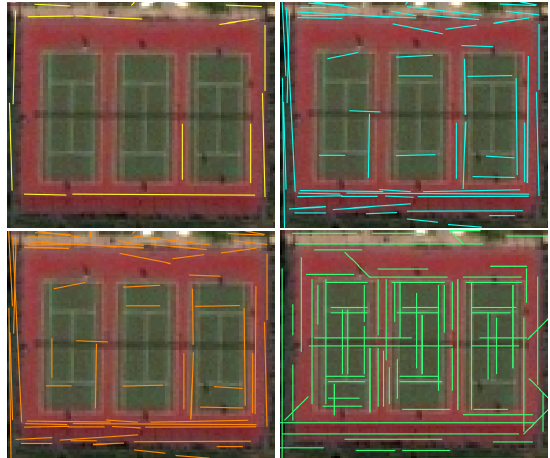
Figure 8. Overlayed results of lines detected by LSD (Yellow), EDLines(light blue), Hough Lines (Orange) and edge accumulator (green). The effects of edge pixels can be seen around the red circles on the slightly rotated lines. detected edges. Firstly, detected and ground truth edges were paired using a proximity threshold of 1.5 pixels. Pairs were es- tablished by selecting the closest near parallel edges. A one to one mapping was enforced to avoid one to many line